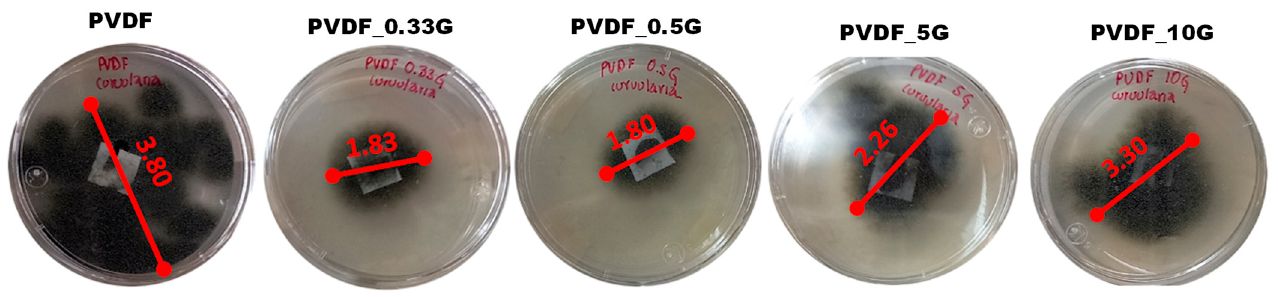
Figure 6. Photographs of antifungal inhibition of all fabricated membranes against Curvularia sp. fungal strain after 72 h.